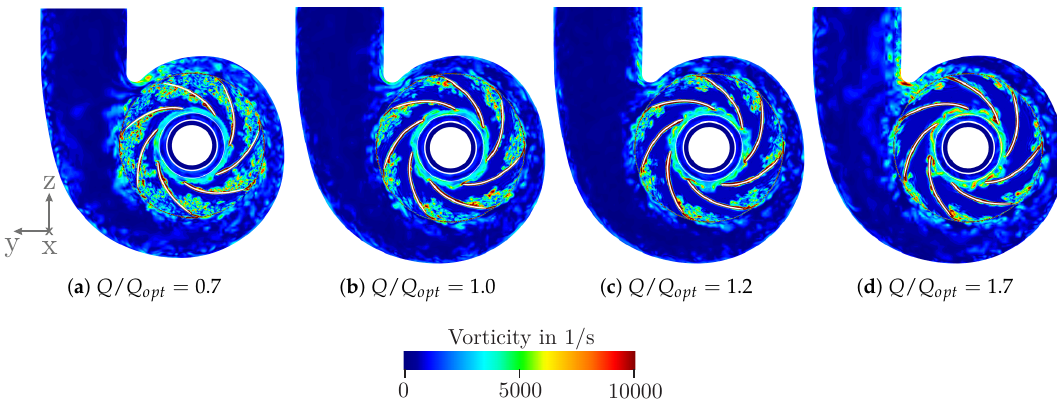
Figure 13. Instantaneous vorticity field on the plane shown in Figure